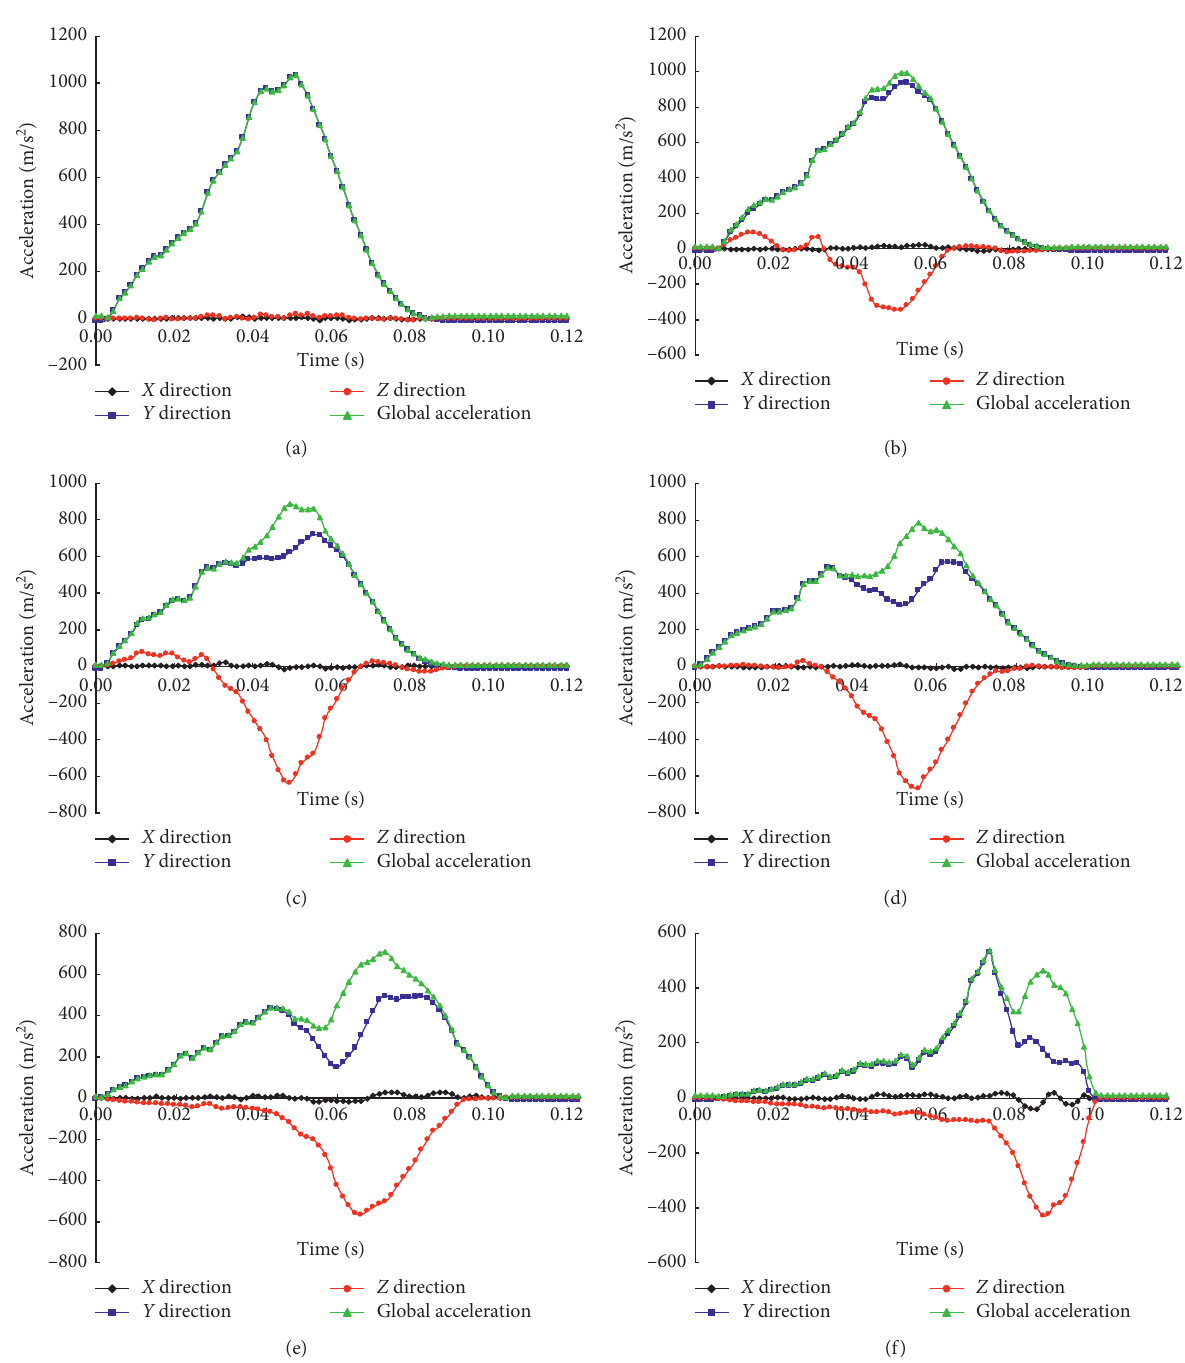
Figure 9: The acceleration time-domain curves of rock fall under different impact angles. (a) Acceleration time-history curve (0 ° ). (b) Acceleration time-history curve (15 ° ). (c) Acceleration time-history curve (30 ° ). (d) Acceleration time-history curve (45 ° ). (e) Ac- celeration time-history curve (60 ° ). (f) Acceleration time-history curve (75 °